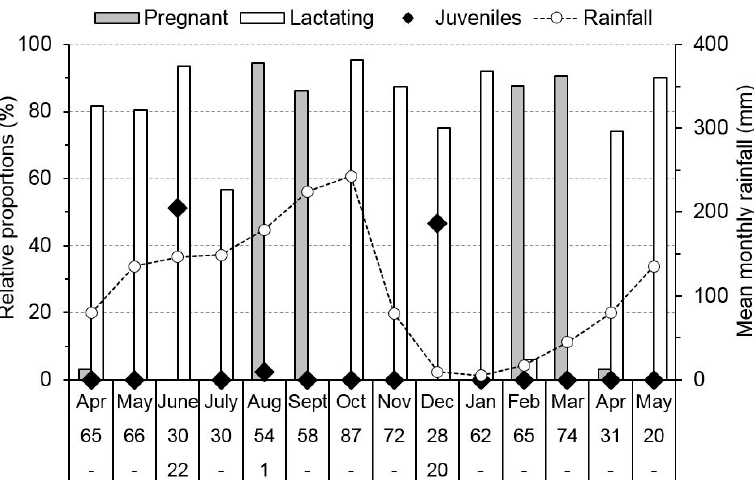
Figure 3. Reproductive phenology of Chaerephon plicatus in Battambang province (north-western Cambodia) in relation to mean monthly rainfall (1982–2013). The first row of figures below the graph represents the total number of parous, pregnant and lactating females caught each month and the second row represents the same for juveniles. Relative proportions for juveniles were derived by dividing monthly totals by the study total × 100. The figure is based on 785 bats captured from April 2015 to May 2016 inclusive.